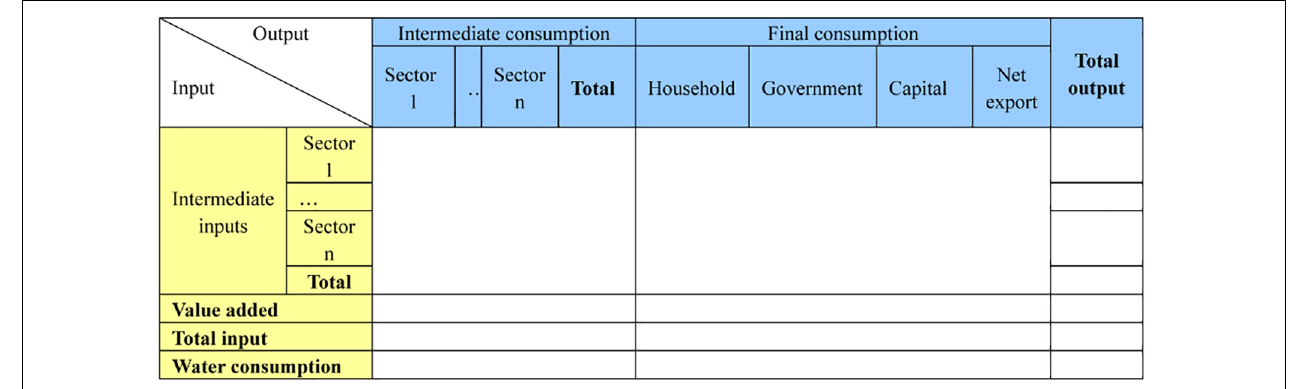
FIGURE 2 | An IO table with water accounts